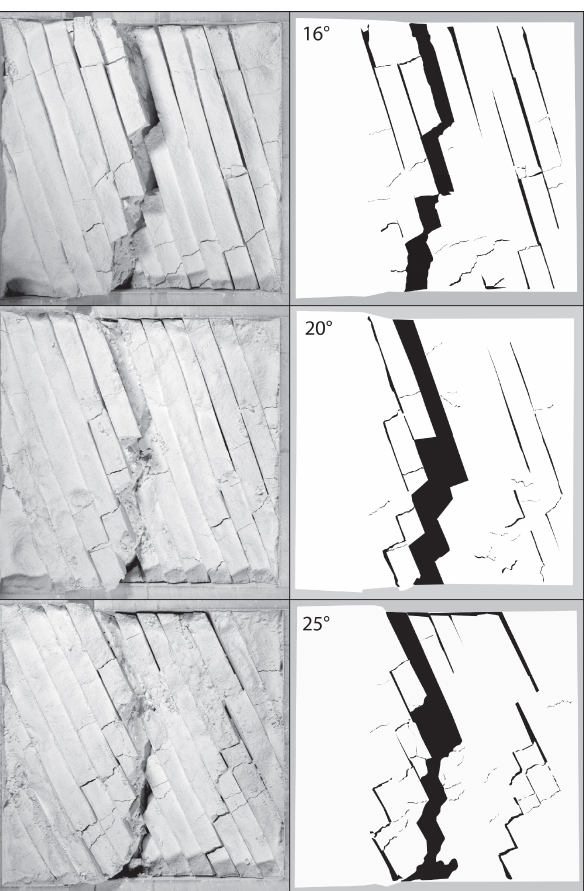
Figure A2. Top-view photographs and interpretation for experi- ments with 16, 20 and 25 ◦